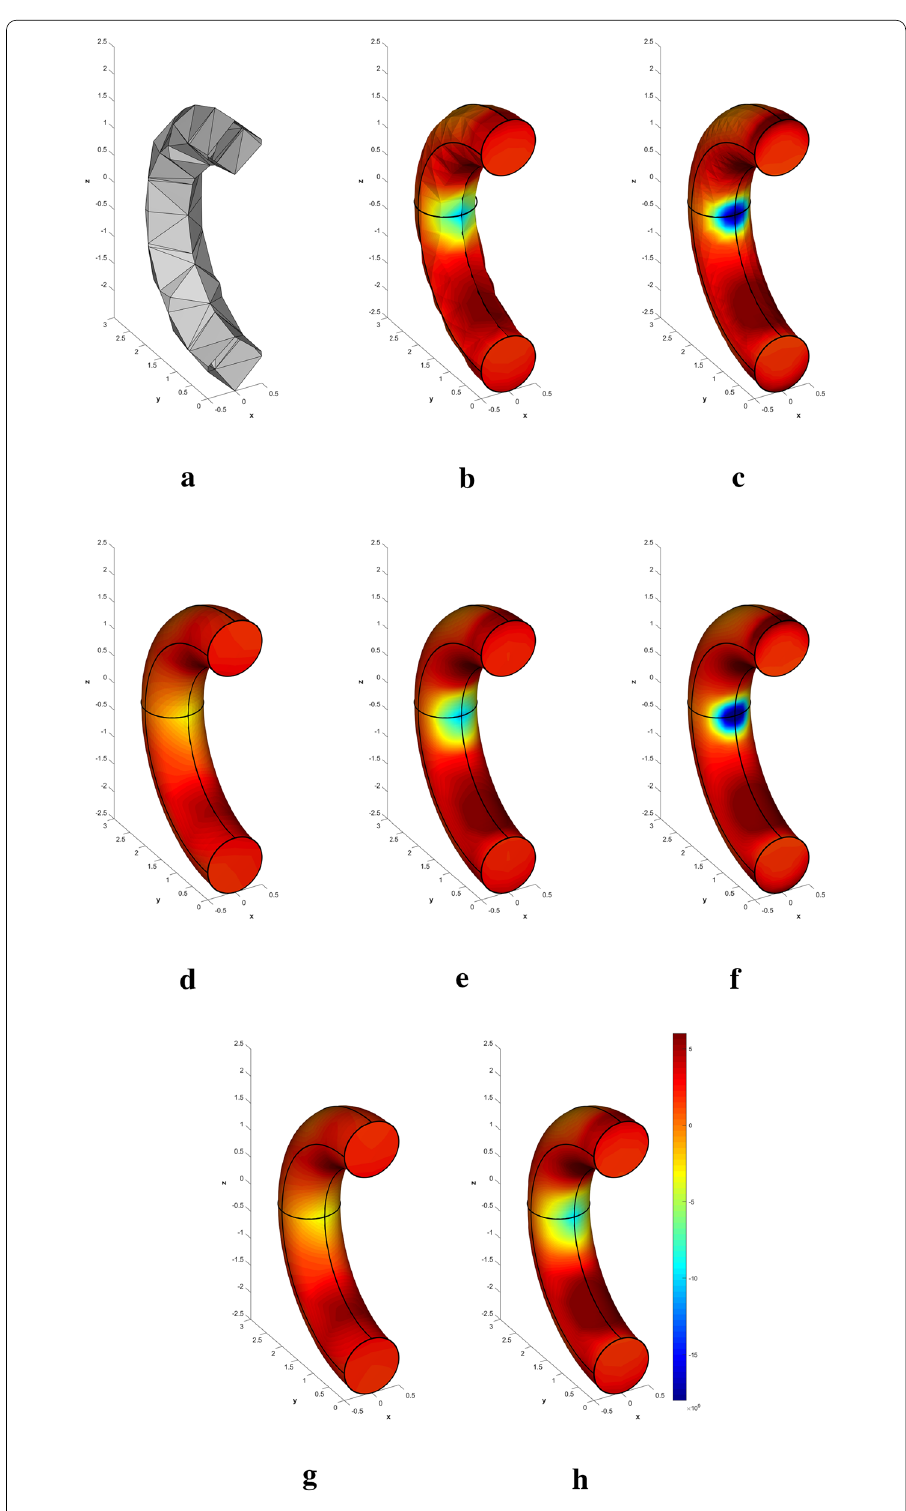
Fig. 14 Example 2. Values of σ y (Pa) at final load step for all the analyses. *The image in a shows the coarse surface discretization which led to loss of convergence. a Linear, mesh 1*. b Linear, mesh 2. c Linear, mesh 3. d NURBS + FE, 1. e NURBS + FE, 2. f NURBS + FE, 3. g NURBS disp., 1. h NURBS disp.,